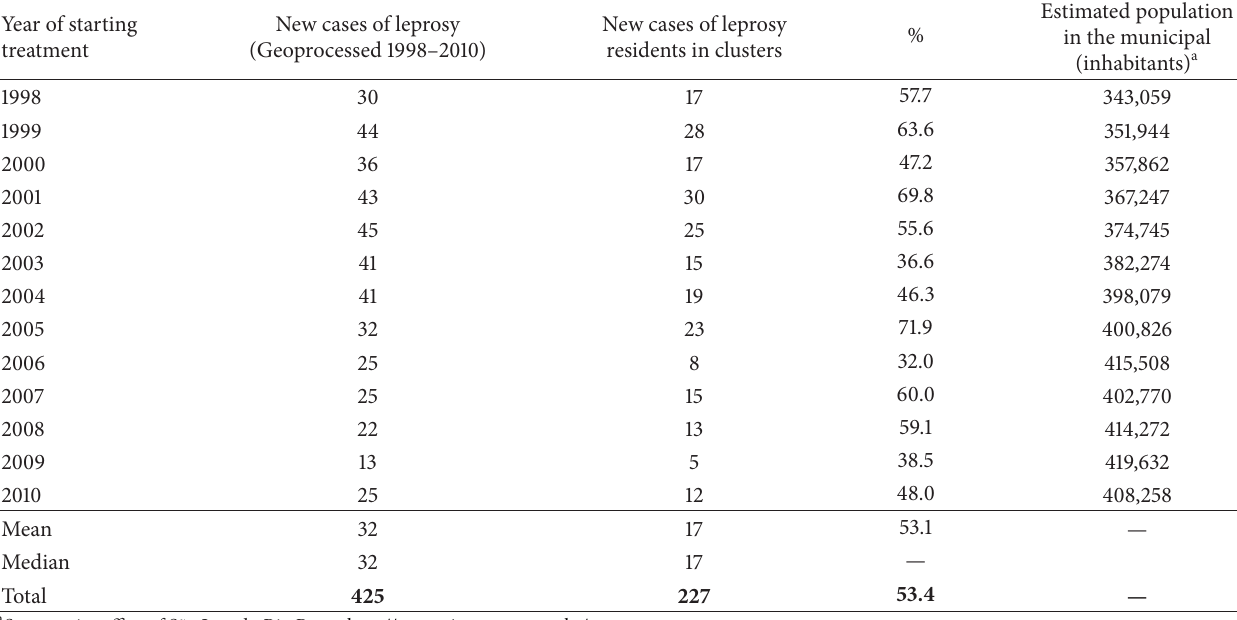
Table 1: Distribution of new leprosy cases in the clusters from 1998 to 2010, according to the new cases geoprocessed and the estimated values of population/year.